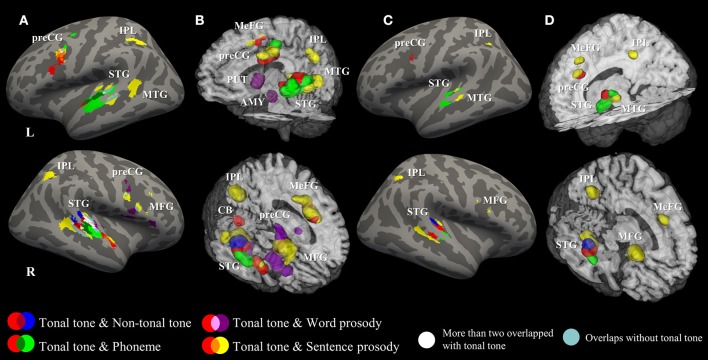
Surface and 3D Rendering maps showing overlaid ALE statistics for all conditions. (A,B) uncorrected p < 0.001, minimum cluster = 540 mm3. (C,D) FDR-corrected p < 0.05, minimum cluster = 100 mm3. AMY, amygdala; CB, cerebellum; IPL, inferior parietal lobule; MFG, middle frontal gyrus; MeFG, medial frontal gyrus; MTG, middle temporal gyrus; preCG, precentral gyrus; PUT, putamen; STG, superior temporal gyrus.